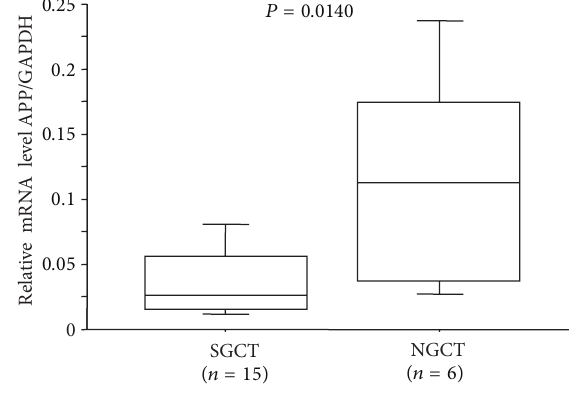
Figure 2: Quantitative RT-PCR analysis of amyloid precursor protein (APP) in seminomatous germ cell tumors (SGCTs) and nonseminomatous germ cell tumors (NGCTs). The figures in box andwhiskerplotshowtherelativemRNAlevelsofAPPquantifiedby normalization to GAPDH mRNA levels. Bars , ± SDs. A statistically significant difference in APP expression was observed between SGCTs and NGCTs ( 𝑃 = 0.0140